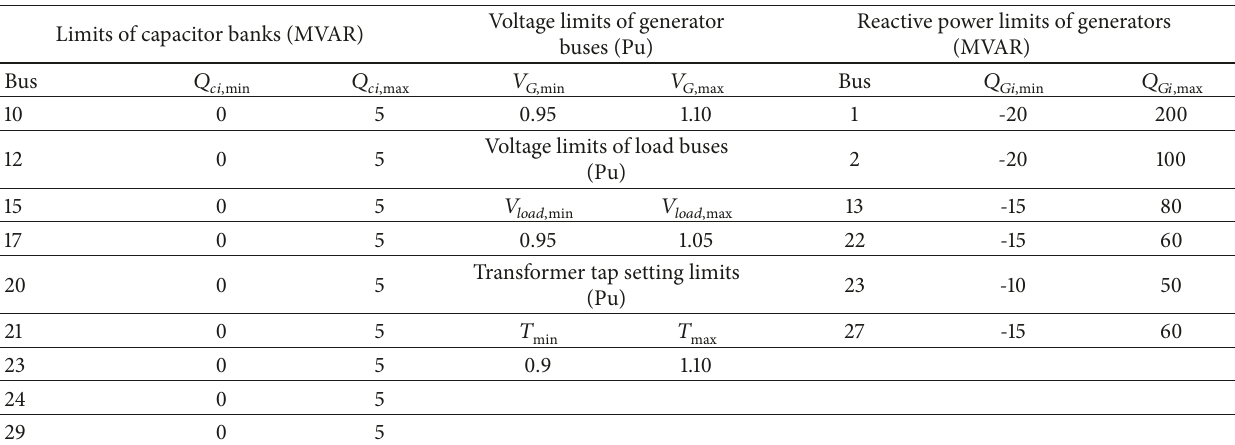
Table 12: Setting limits for IEEE 30-bus system.